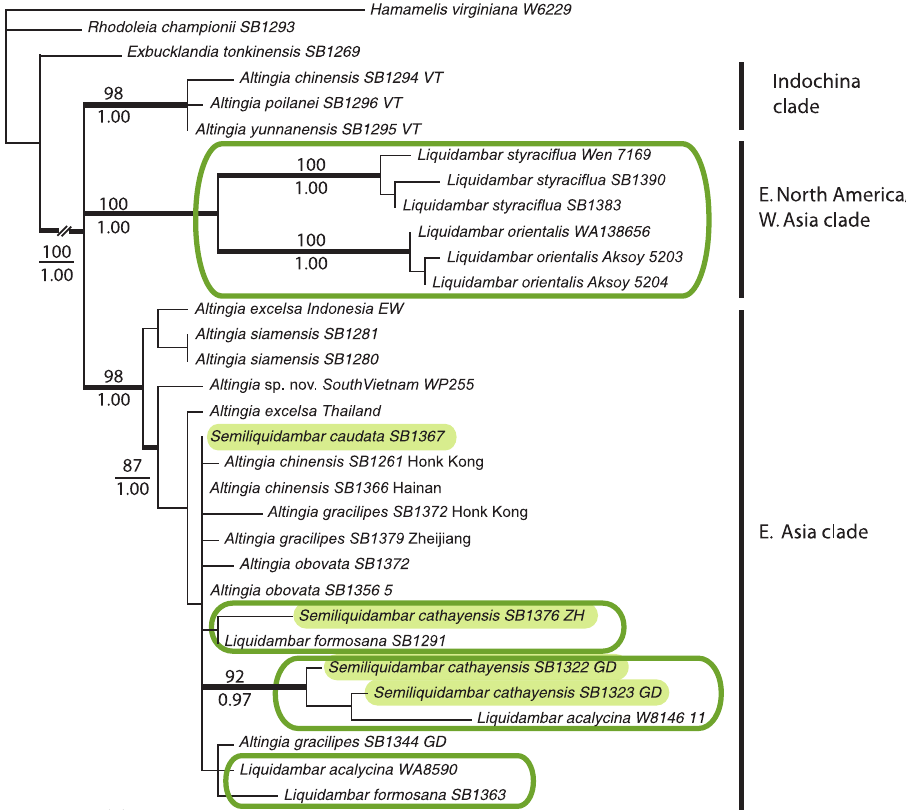
Figure 1. Phylogenetic relationships of Altingiaceae based on maximum likelihood analyses of combined cp DNA data. Phylogram is one of 14 trees (-In L =9927.72) derived from maximum likelihood analyses showing rates of substitution under K81uf+I model of substitution evolution (Modified from Ickert- Bond and Wen 2006). Note: Break in branch lengths for the OG at left, and Semiliquidambar taxa with green shaded boxes, clades that include Liquidambar taxa have green outline